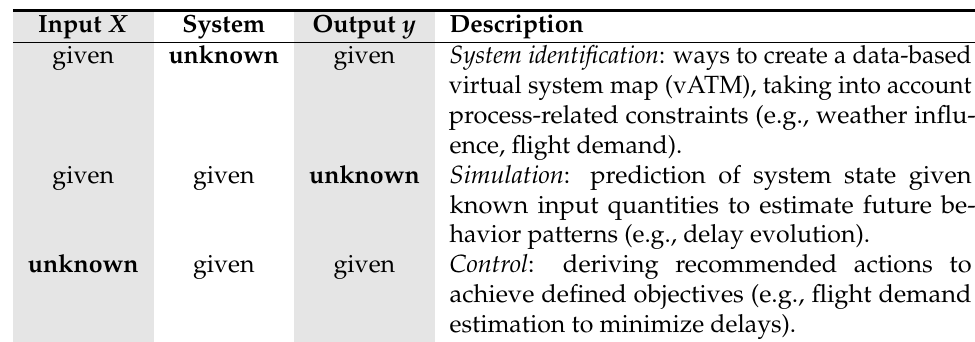
Figure 5. Application components of a vATM. ( a ) System identification; ( b ) simulation; ( c ) control. Table 3. The three core components system identification, control and simulation in the application of